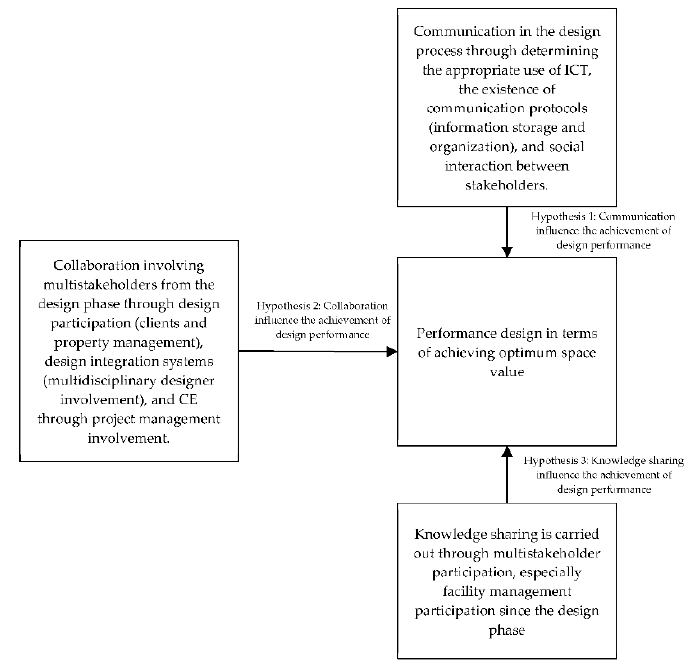
Figure 2. The conceptual model of performance design.